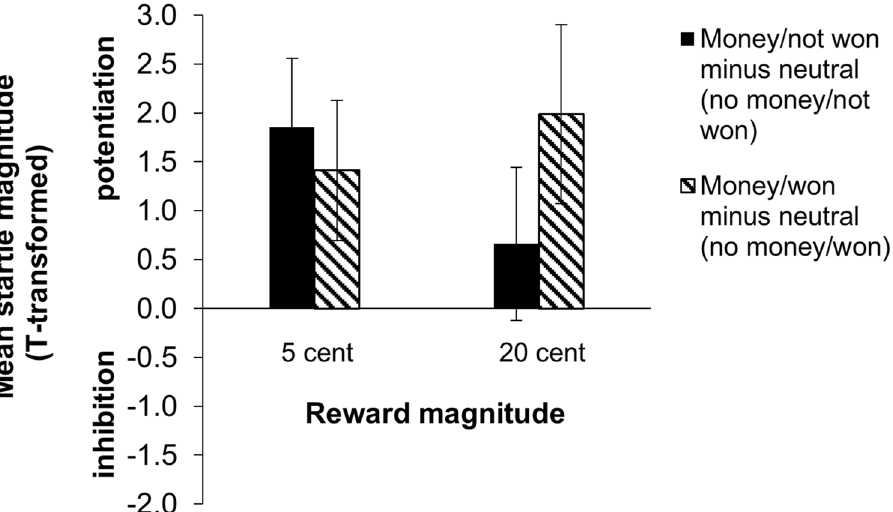
Figure 5. Mean startle magnitudes during the feedback phase of Experiment 2. Black bars represent the money potential/not won condition minus the respective neutral condition without potential gain (i.e., no money potential/not won). Striped bars represent the money potential/won condition minus the respective neutral condition without potential gain (i.e., no money potential/won). The win potential conditions (no money, 5 cent, and 20 cent) were manipulated within-subject. Startle magnitudes were significantly increased when 5 cents was at stake compared to the neutral condition without potential gain, irrespective of the actual outcome of the trial (in the Figure this can be seen as the average of the two bars on the left being significantly greater than 0). Error bars represent ± standard error of the mean. Note that z -scores are transformed to t -scores for illustrative purposes. Figure S2 in the Supplementary materials presents the t-values for all conditions including the neutral conditions